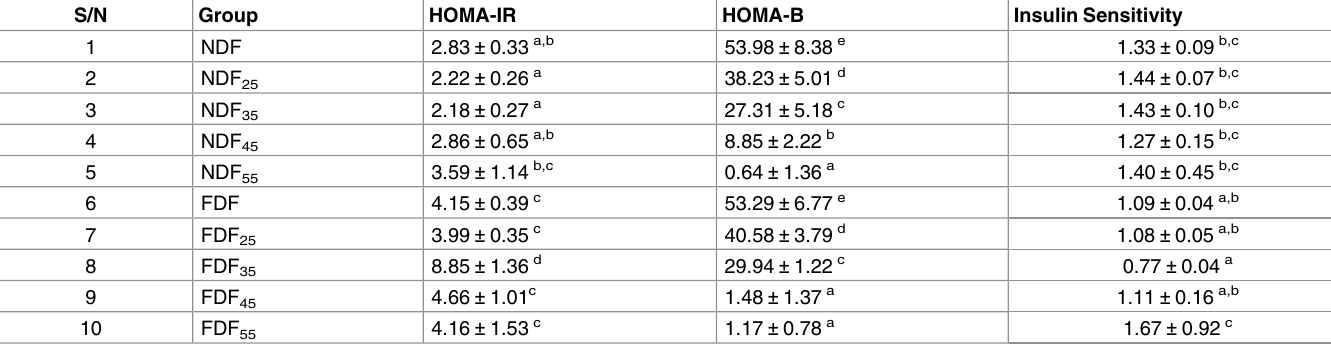
Table 5. Evaluation of the Beta-Cell Function and Insulin Sensitivity/Resistance of the Rats.